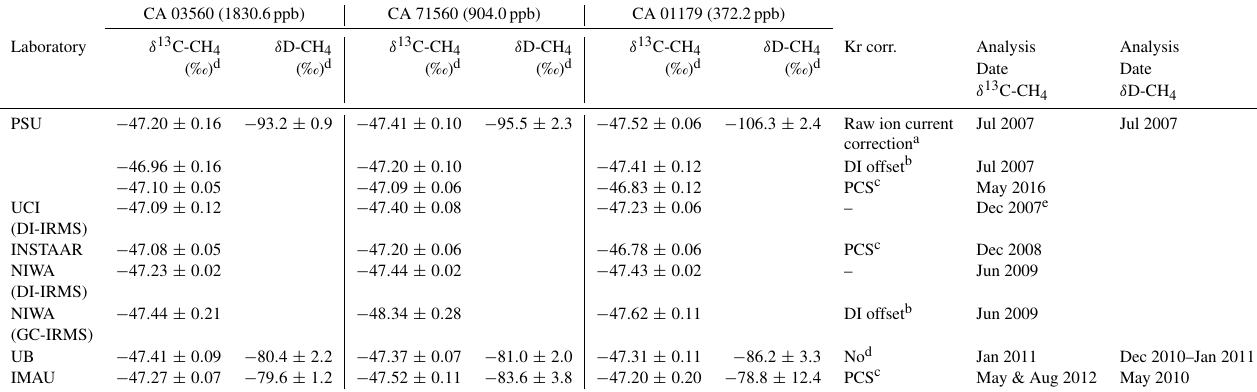
Table 5. Results from the round robin comparison of ice core analysis laboratories conducted during 2007–2016.